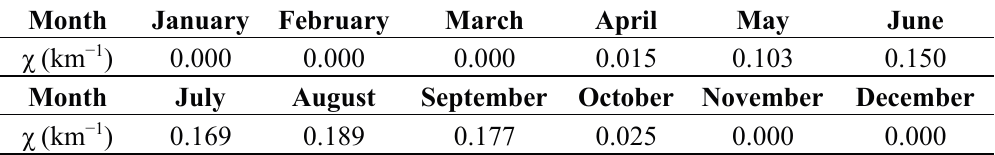
Table 1. Monthly precipitation-adjustment factors in the arid land of northwestern